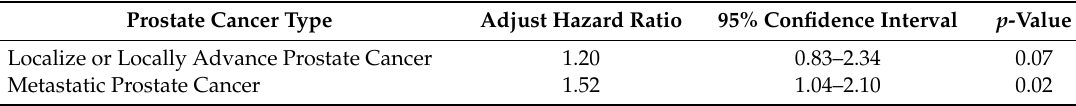
Table 3. Mortality in national prostate cancer cohort, analyzed by multivariable cox proportional hazards regression model and 95% confidence intervals.